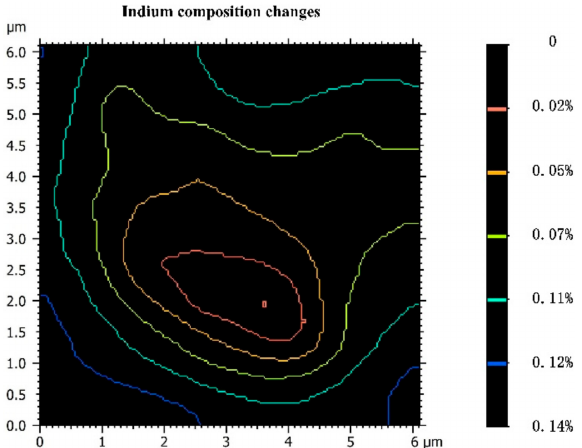
Figure 7. Simulation of In composition increment in the vicinity of the dark spot (the central point corresponds to the maximum degree of the In segregation